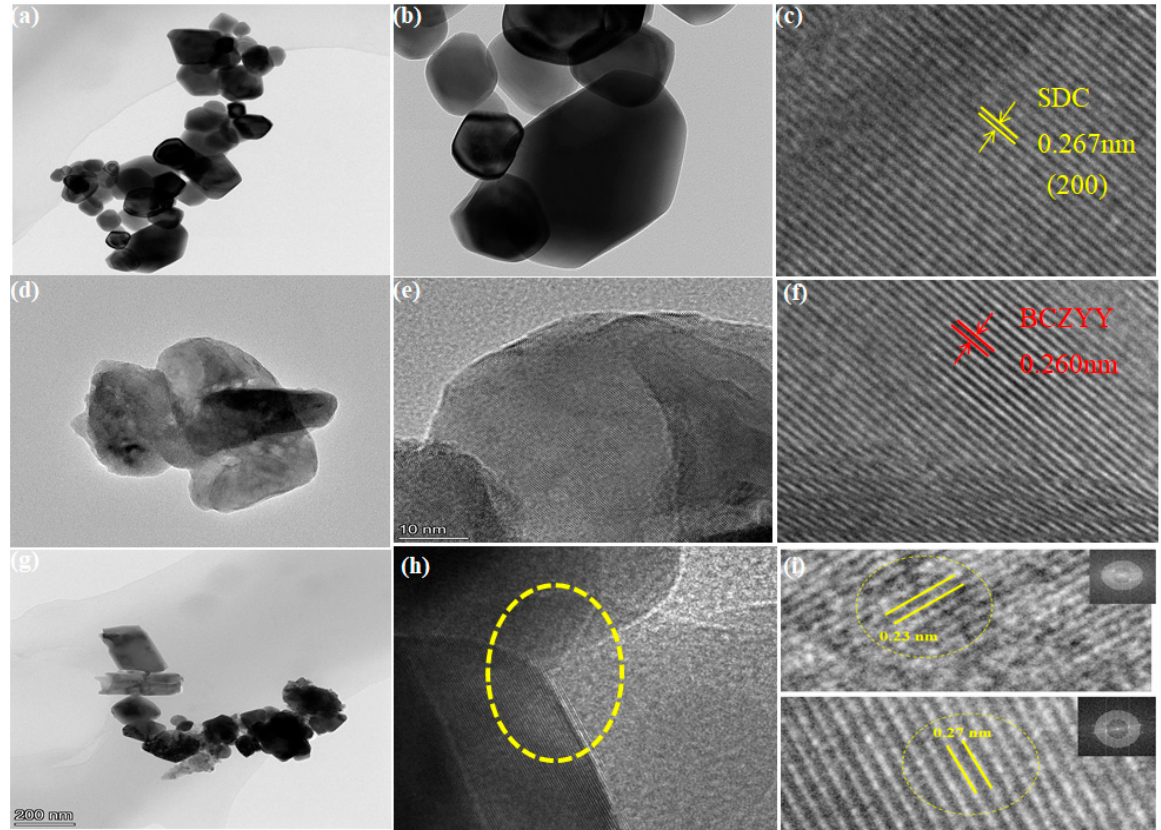
Figure 2. ( a – c ) HR-TEM images and crystal plane (111) of SDC with d-spacing values, ( d – f ) BCZYYb with crystal plane of (110) with d-spacing values and ( g – i ) HR-TEM image of composite BCZYYb-SDC heterostructure image with different planes of (111) and (110), respectively.